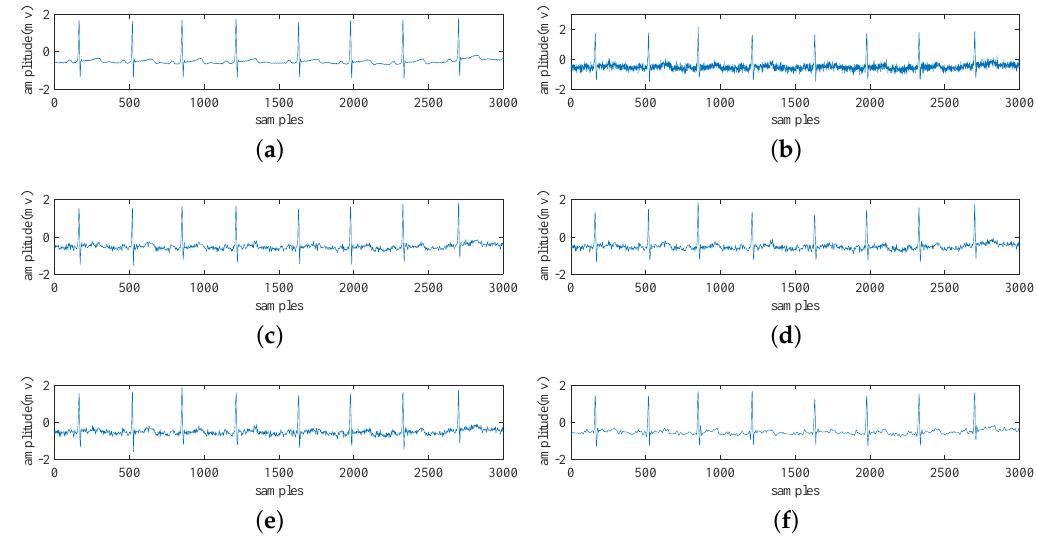
Figure 7. The de-noising results after adding EMG noise to No. 115 record of the MIT-BIH database: ( a ) The original signal. ( b ) The signal after adding EMG noise. ( c – f ) De-noised signals using wavelet soft threshold, EMD, EMD soft threshold, proposed method.